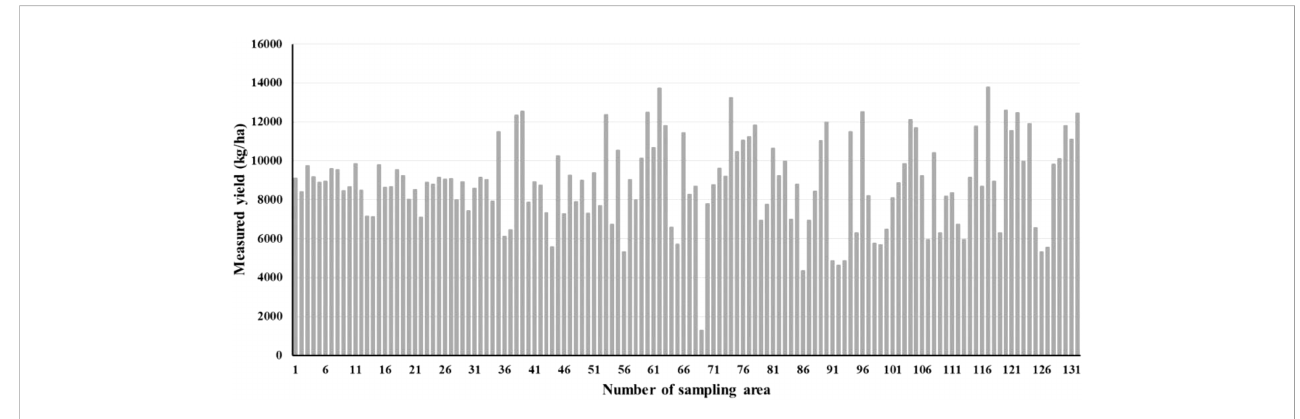
FIGURE 3 Bar plot showing the measured maize yield in the sampling